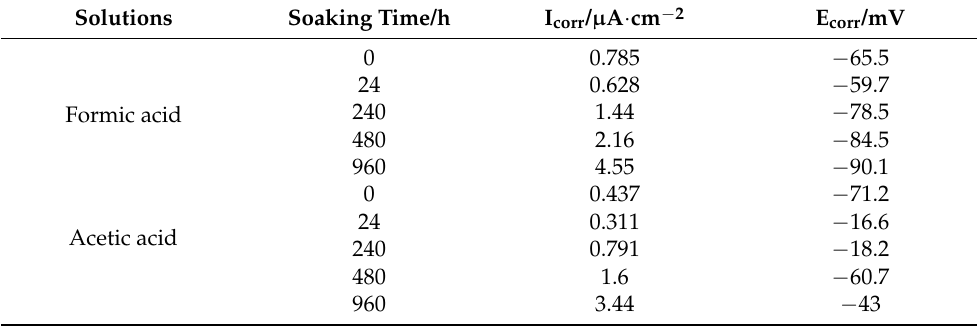
Figure 2. Polarization curves of copper after different soaking time in 1% organic acid solution: ( a ) Formic acid; ( b ) Acetic acid. Table 1. Self-corrosion potential and self-corrosion current density of copper in formic and acetic acid solution.